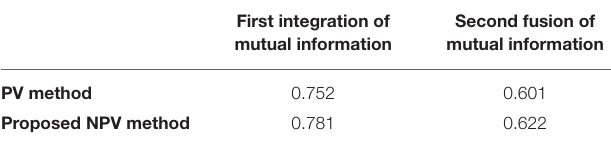
TABLE 1 | Comparison of mutual information fusion